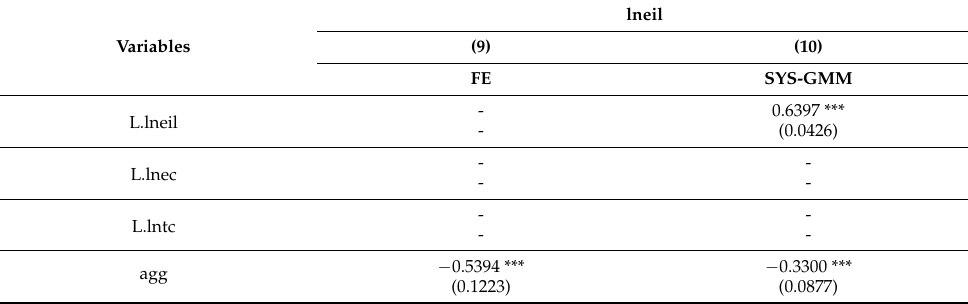
Table 7. Endogenous test